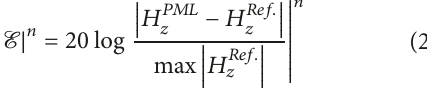
vacuum domain contains 101 × 101 cells and the